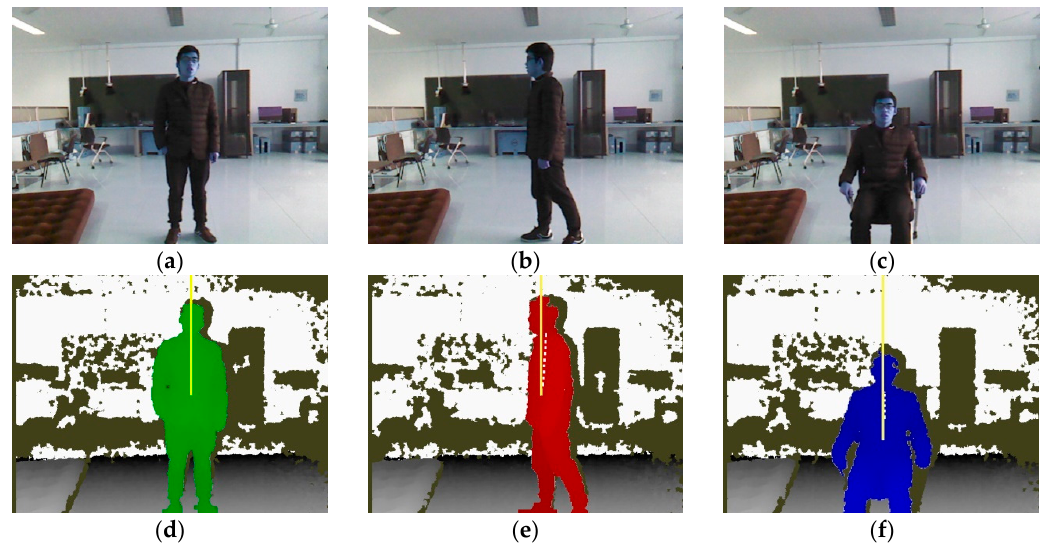
Figure 4. The torso angles in three common daily activities. ( a – c ) the RGB images of standing, walking and sitting; ( d – f ) their depth images, where the solid line is the gravity line and the dotted line is the torso line.